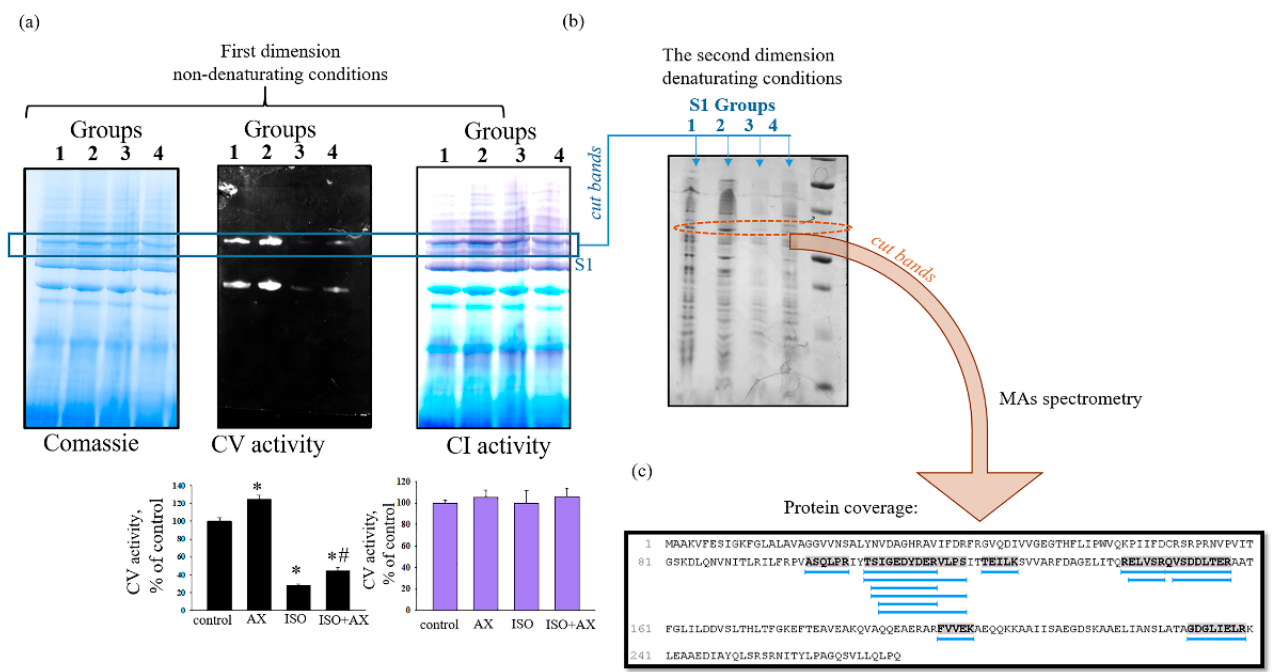
Figure 3. The effect of chronic treatment of AX on the activity of supercomplexes (SCs) in rat heart mitochondria in heart failure. ( a )—the first dimension after separation of the mitochondrial suspension by BNE (non-denaturing condition) Coomassie staining, Complex V and I activity (upper part); diagram reflecting the change in the activity of Complexes V and I (low part). Optic density of Coomassie bands was used as a loading control; ( b )—the second dimension (Laemmli system under denaturing conditions) after cutting strips from the gel after the first measurement; ( c )—the analysis of the amino acid sequence (protein coverage). Data are presented as means ±SDs of four independent experiments. * p < 0.05 indicates a significant difference in the protein level relative to the control (group 1). # p < 0.05 compared to RHM isolated from ISO-injected rats (group 3). The statistical significance of the differences between the pairs of the mean values was evaluated using an ANOVA type 2 (Student–Newman–Keuls) test.